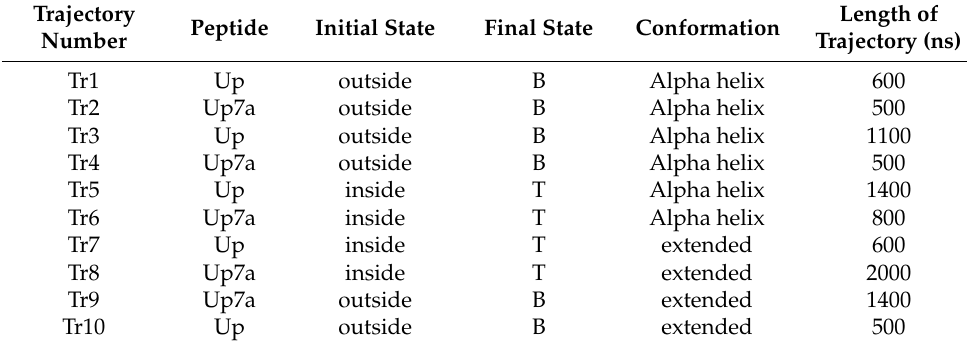
Table 1. Simulation